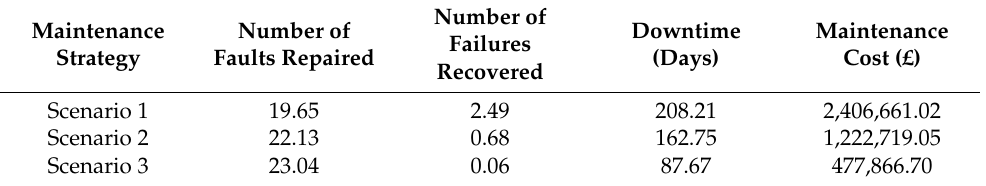
Table 5. Impact of the application and quality of the CMS on the operation and maintenance (O&M).